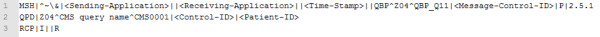
Example of an HL7 Query to the Consent Management Service. Queries are built using the HL7 Query/Response conformance statements. The message header (MSH) segment contains meta data including: the sending and receiving application, time stamps and versions. The essential part of the message is the query parameter definition (QPD) segment including the query characteristics. Possible values are defined and specified among the affinity domain members.